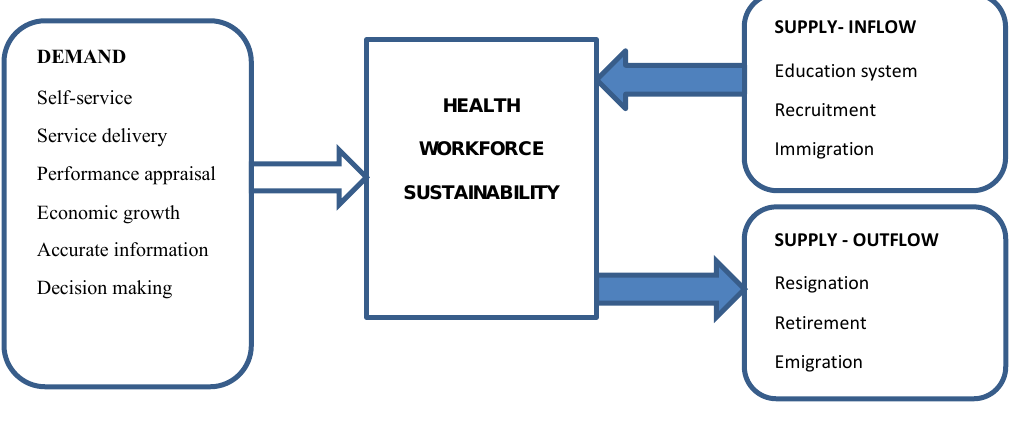
Figure 1: HRIS drivers of demand and supply of health workforce for service delivery; Source: Boskovic et al. (2021) Figure 1 identifies the relationship between HRIS usage and health workforce sustainability with the impact of workforce supply compared to the demand of HRIS usage in the health sector. The effectiveness of HRIS argues Boskovic et al. (2021) can assist to equate the demand of the information system and the supply of skilled workforce.